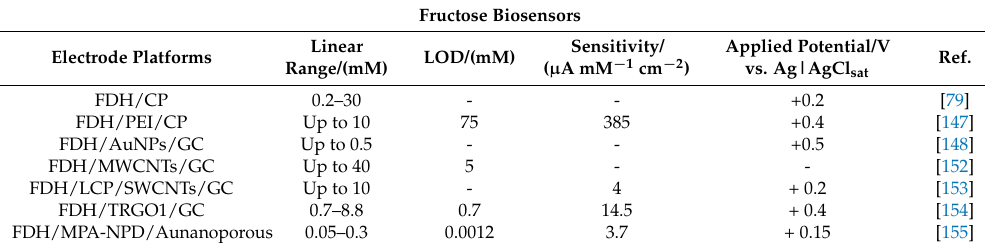
Table 4. Fructose biosensors based on DET of FDH are compared based on several analytical parameters like linear range, LOD, sensitivity, applied potential and stability. Abbreviations: Aunanoporous